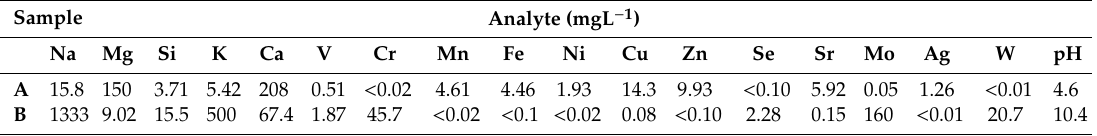
Table 1. Chemical composition of industrial waste water